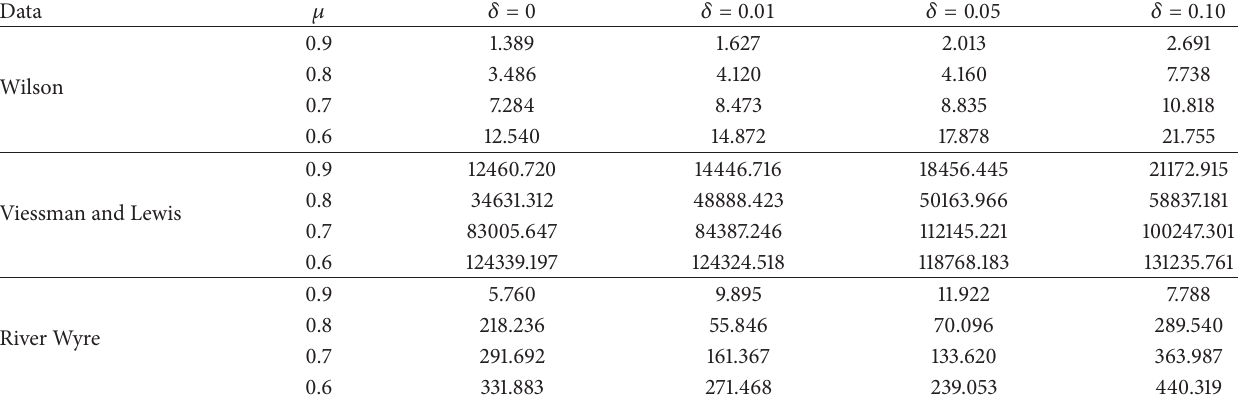
Table 4: Average SSE values of the SVM approach for Wilson data, Viessman and Lewis data, and River Wyre data. Data